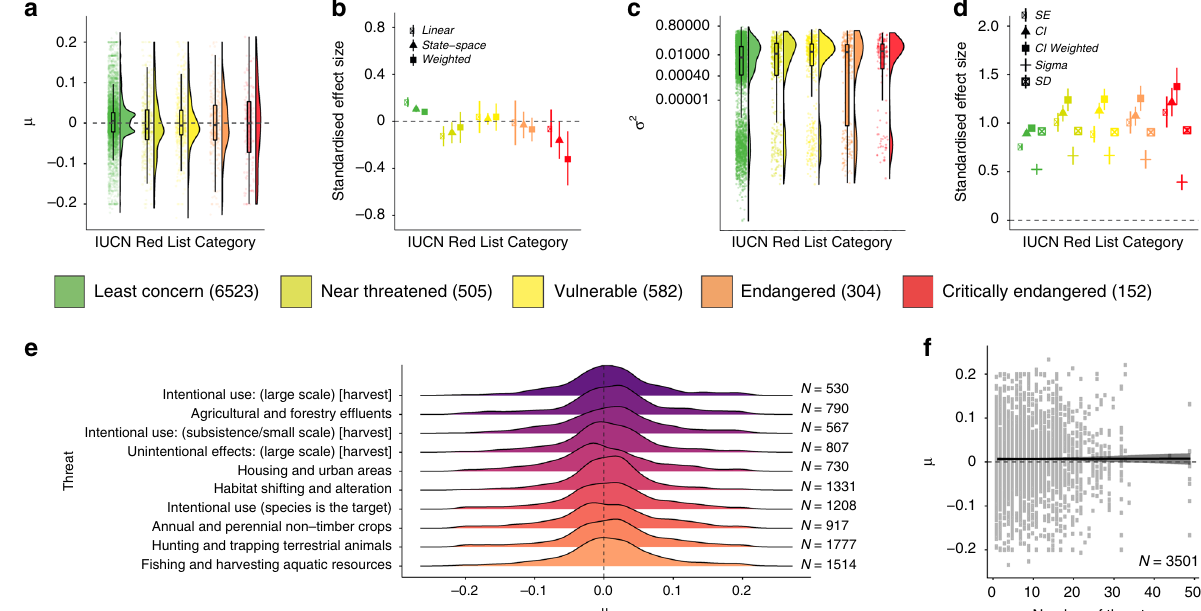
Fig. 4 On local scales, there are increasing, decreasing and stable populations across the full spectrum of the globally-determined species ’ IUCN Red List Categories and anthropogenic threat type from the species ’ IUCN Red List pro fi les. Numbers in the legend for a – d and in e – f show sample size for each metric. a , c show the density distributions of population trends across IUCN Red List Categories, the raw values (points) and boxplots with the mean, fi rst and third quartiles and boxplot whiskers that indicate the distance that covers 1.5 times the interquartile range. b and d show the standardised effect sizes (centre of error bars) and the 95% credible intervals of population trends b and fl uctuations d across IUCN Red List Categories. The μ values of population trend a , e , f and the σ 2 values of population fl uctuation c were derived from state-space model fi ts of changes in abundance over time for each population. For the relationships between type and number of threats and population fl uctuations, see Supplementary Fig. 18. e shows the distributions of population trends across different threats that the species face globally, with the central tendencies of all distributions overlapping with zero. Lines in f show model fi t and 95% credible intervals, where ‘ number of threats ’ refers to the number of different threats that each species, whose populations are locally monitored, are exposed to on a global scale. See Fig. 1 caption for further details on effect sizes, Methods for details on deriving the number and types of threats and Table S2 for model